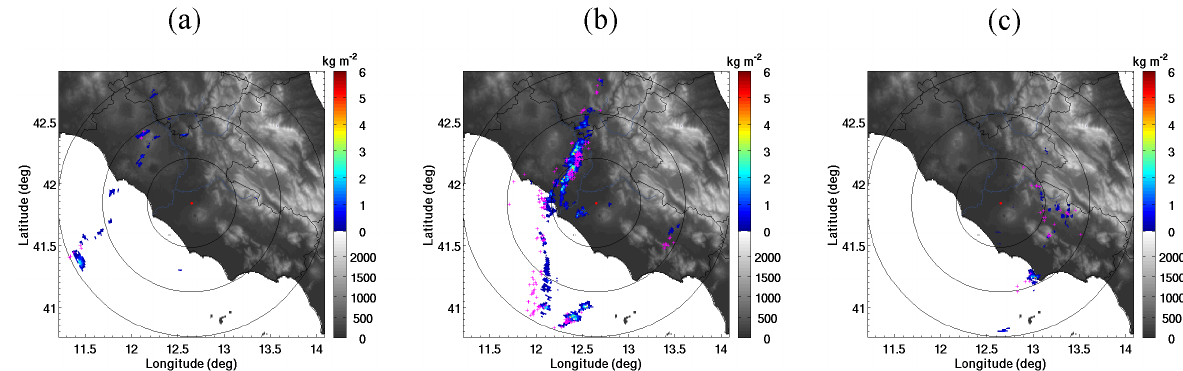
Figure 7. The columnar IWC g estimated from Polar 55C at 16:00UTC (a) , 17:30UTC (b) , and 19:20UTC (c) on the 15 October 2012. Strokes detected by LINET network are represented by the magenta